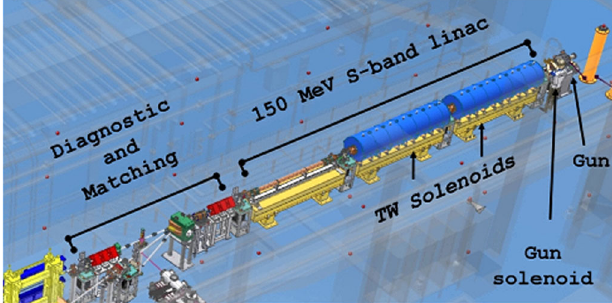
FIG. 1. Layout of SPARC linac and matching section. The two blue cylinders around the first two accelerating cavities represent the iron jokes of the TW